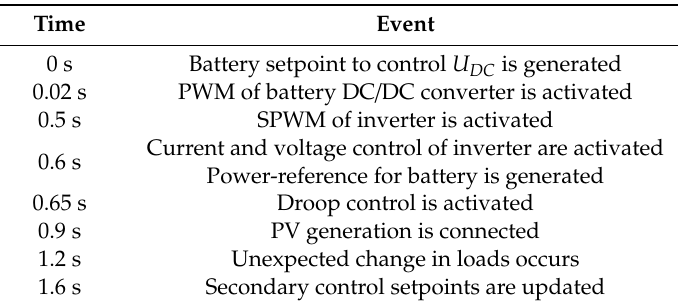
Table 4. Time sequence of the nanogrid simulation.